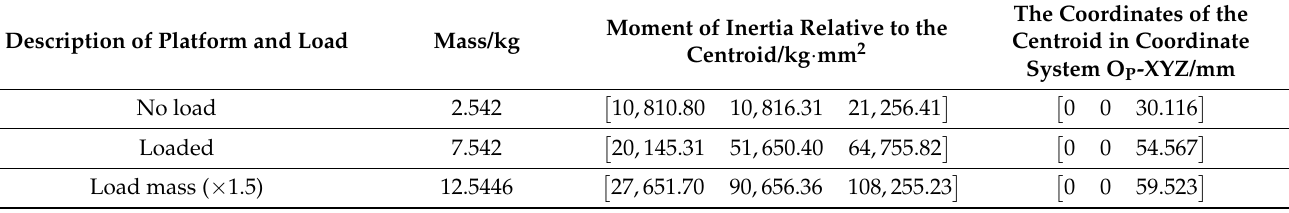
Table A2. The parameters of load and upper platform mass